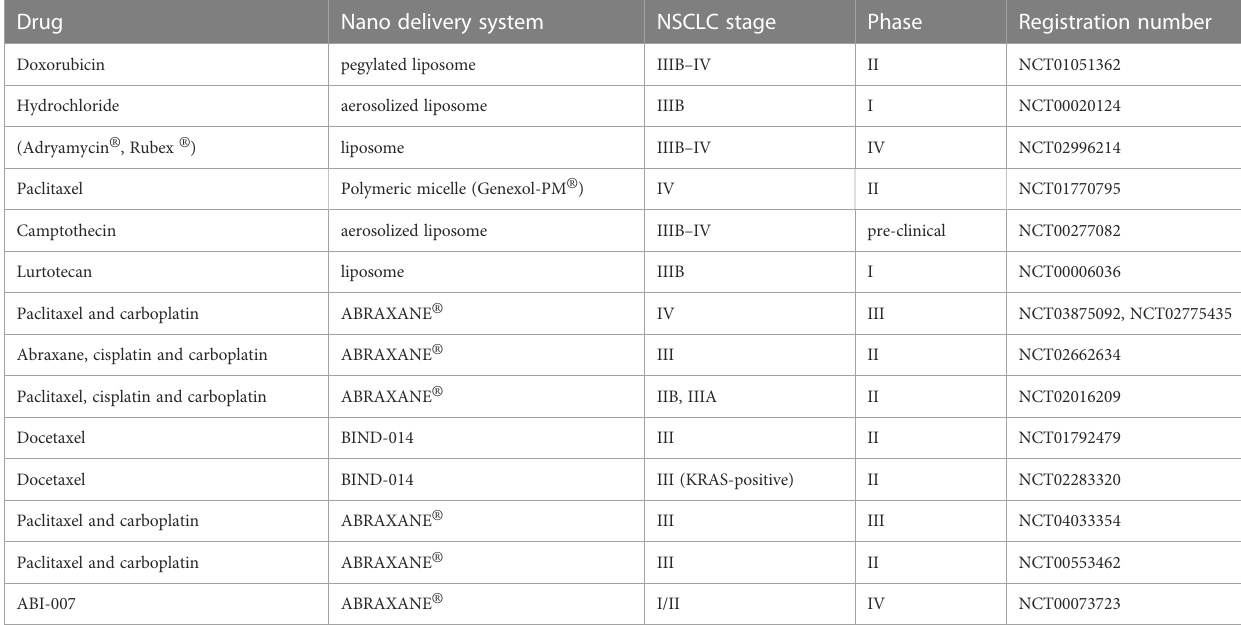
TABLE 1 Currently available nanomedicine-based chemotherapeutic drugs in clinical trials.